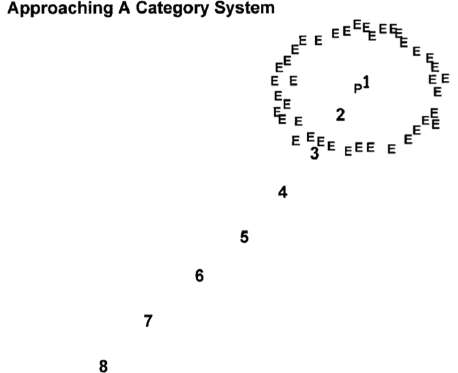
Figure 1. Schematic drawing of a series of hypothetical to be classified items (8 to 1) that are made to approach the psychological space of a category system containing a central prototype (P) and a shell of training exemplars (E). Reprinted from [33]. Copyright 2002 by the Association for Psychological Science. Reprinted with permission.